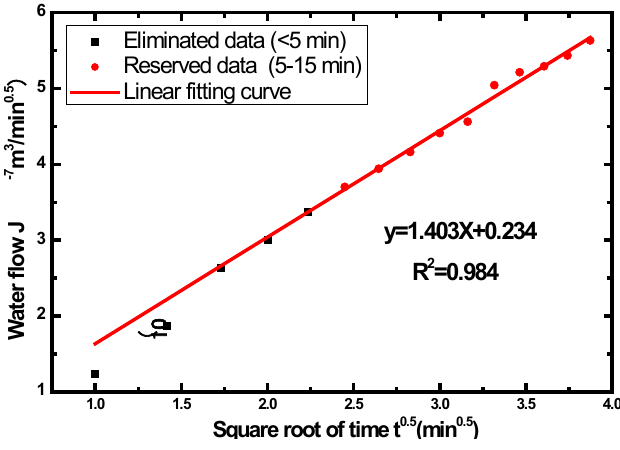
Figure 2. Water permeability results of concrete CF15 and their trend line.